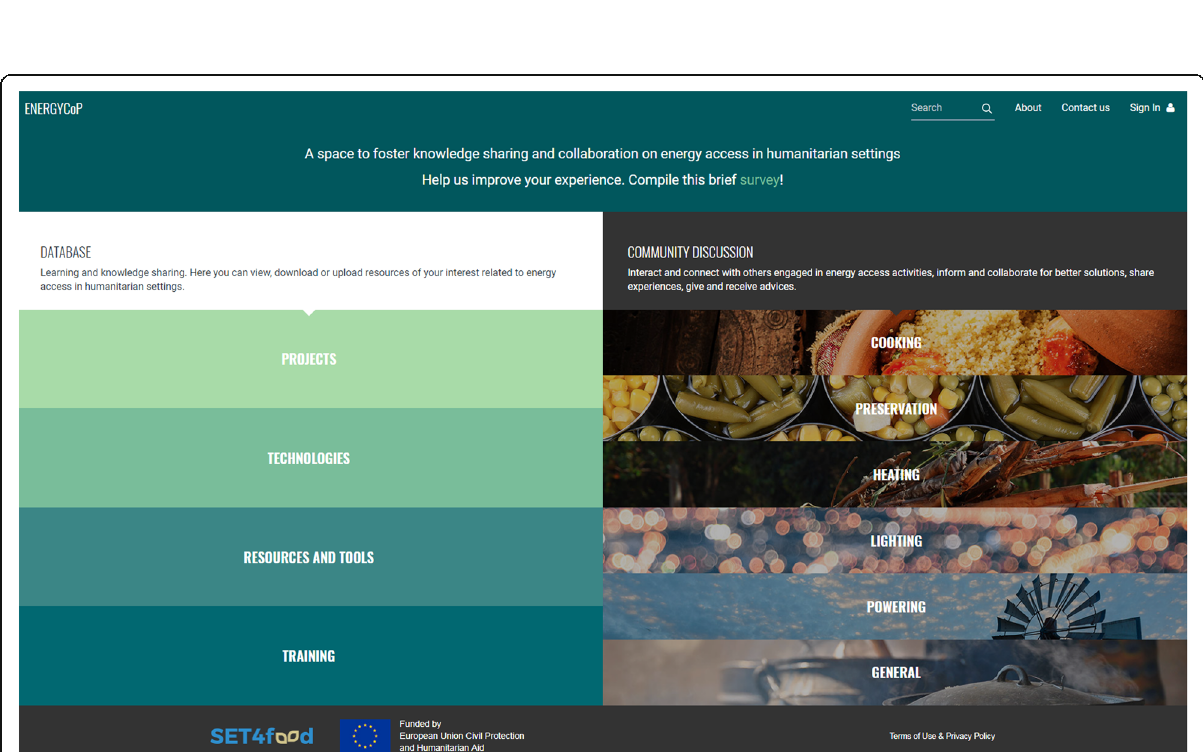
Fig. 12 The ENERGYCoP homepage